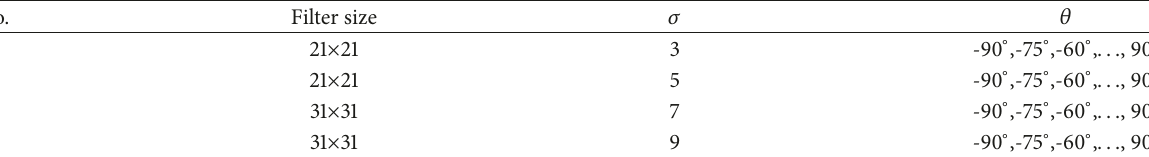
Figure 4: Examples of pavement 3D data rectification: (a) and (b) the original transverse profile and longitudinal profile; (c) and (d) the corresponding transverse profile and longitudinal profile. Table 1: Composition of the